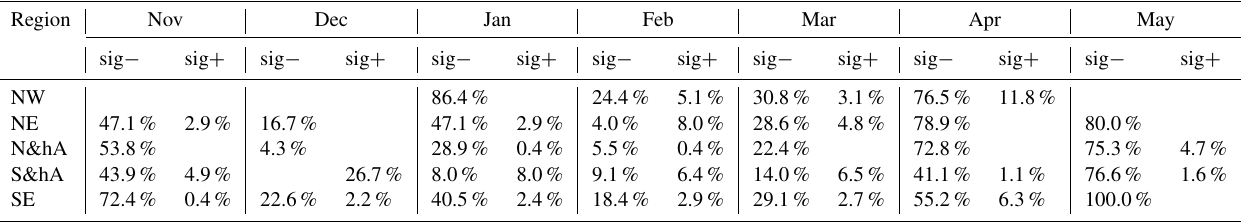
Table B2. Fraction of models with significantly positive or negative changes in the error variance by time. The remaining percentage (not shown) corresponds to the total of non-significant negative and positive changes. Empty cells indicate no stations with significant negative or positive trends (sig − and sig + ) . Changes were considered significant if the GLS model with a time coefficient for the error variance showed significantly improved goodness of fit compared to the OLS model with constant error variance ( p < 0.05).